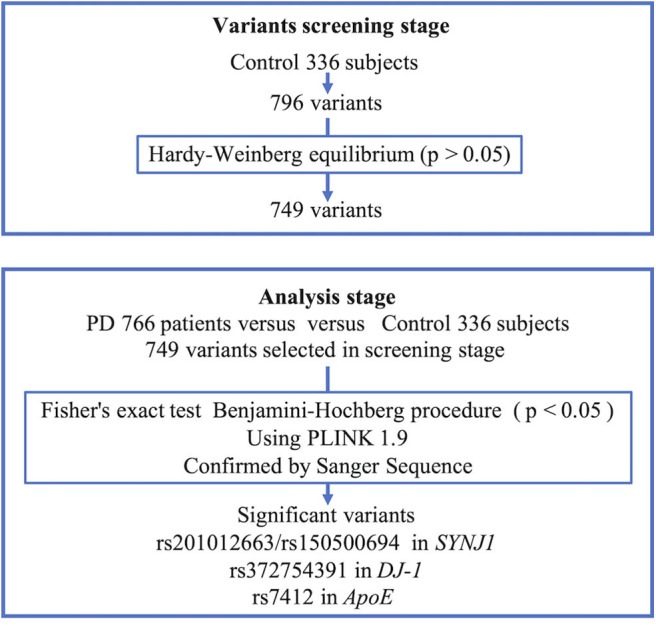
Scheme of analysis. PD, Parkinson's disease; SYNJ1, Synaptojanin 1; APOE, Apolipoprotein E.